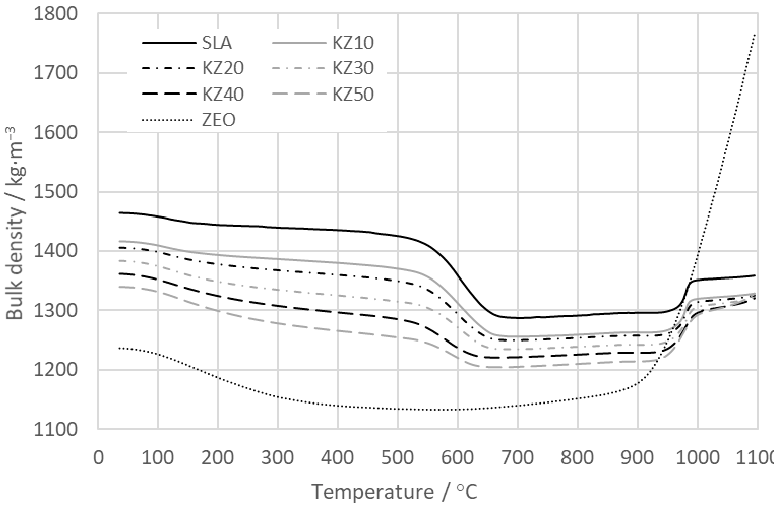
Figure 8. Bulk density of the studied